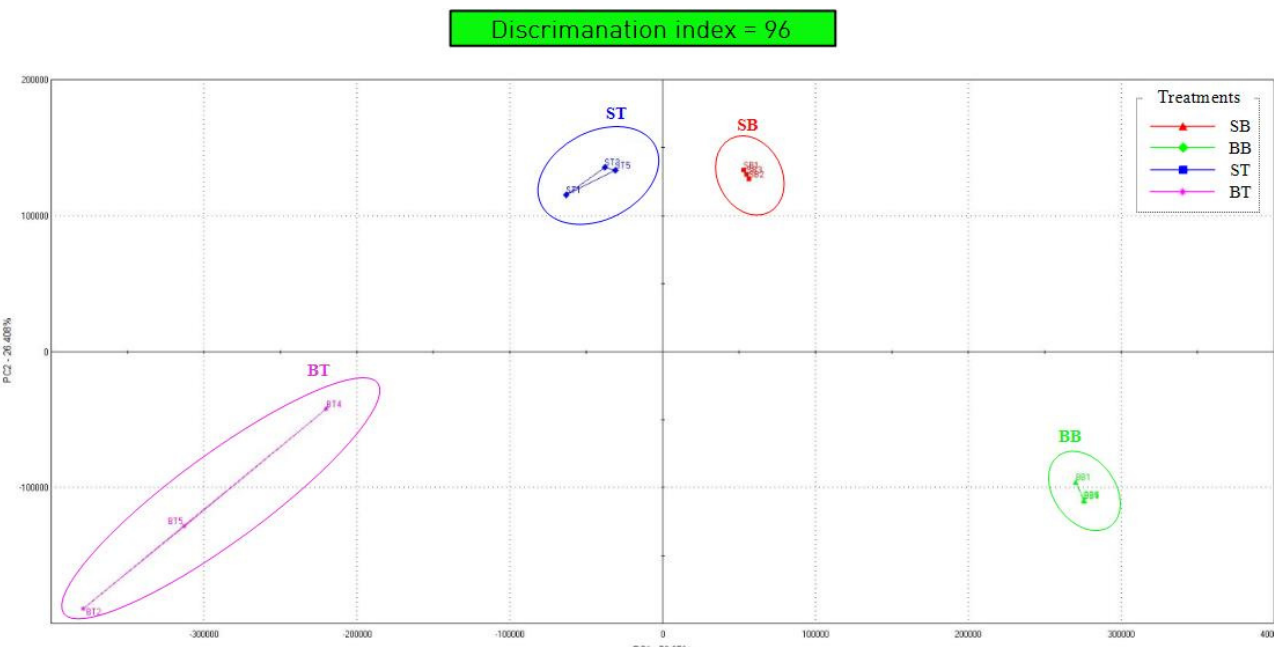
Figure 3. Principal component analysis using an electronic nose on the breast and thigh of spent hens and broilers. SB, spent hens breast; BB, broilers breast; ST, spent hens thigh; BT, broilers thigh.